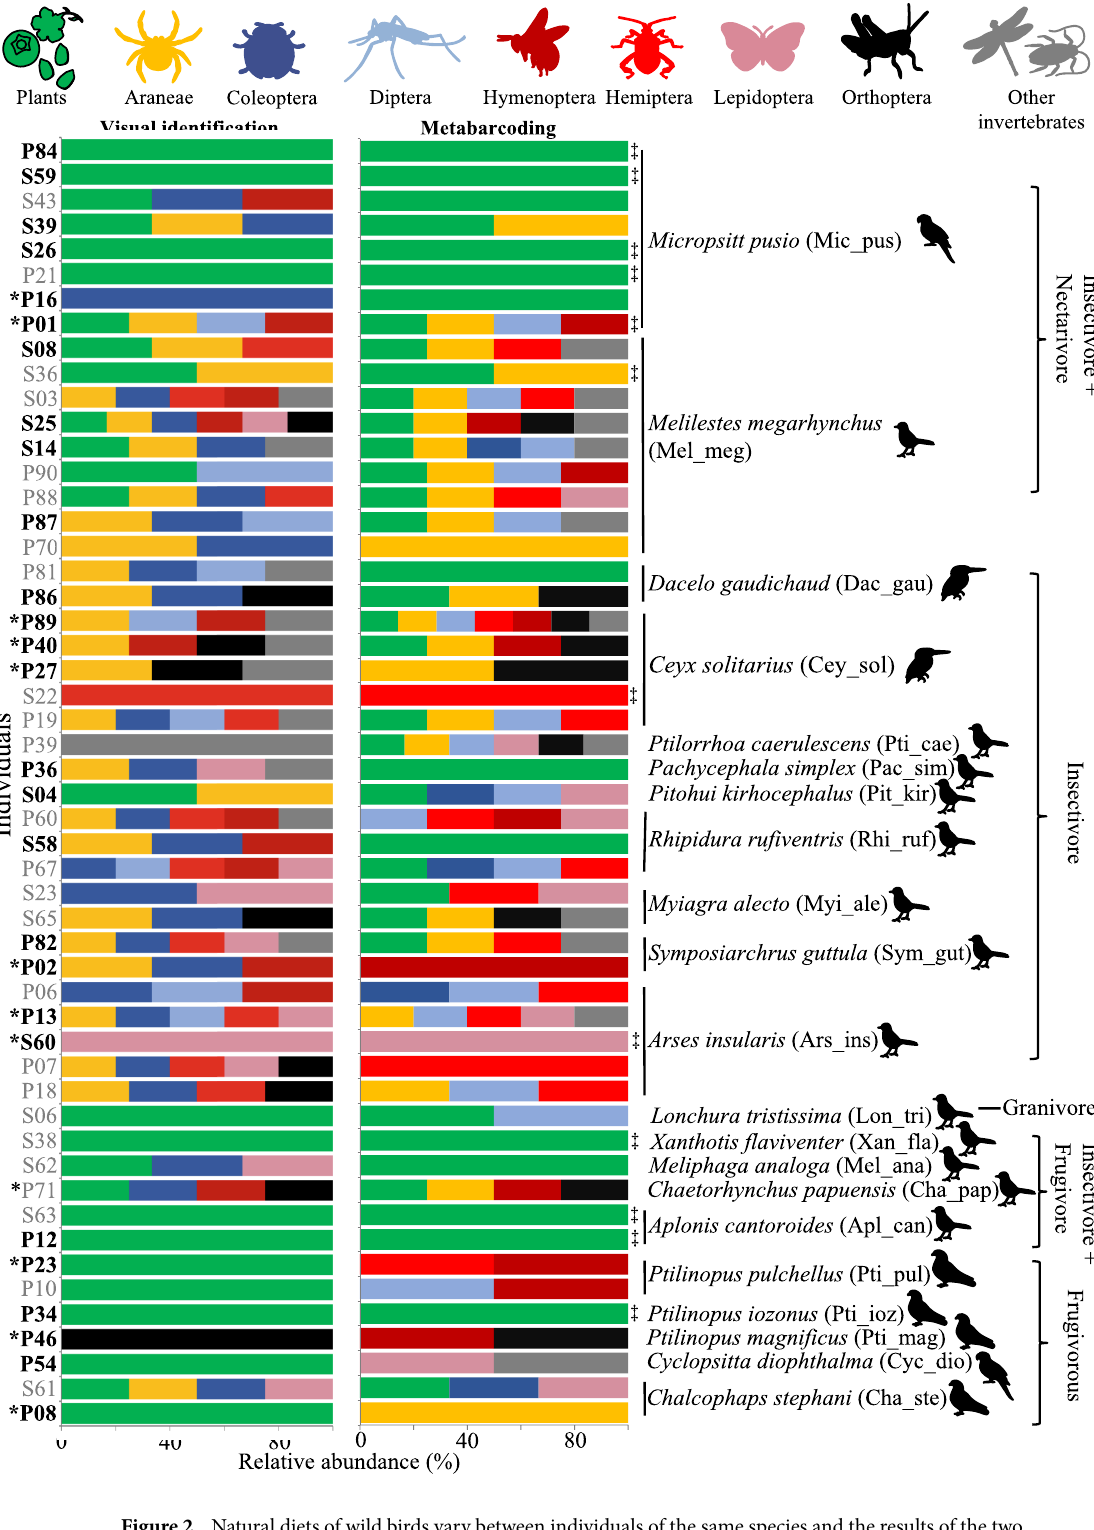
Figure 2. Natural diets of wild birds vary between individuals of the same species and the results of the two identification methods of dietary components (visual identification and metabarcoding). Relative abundances based on the presence/absence of data of different dietary components are indicated in colours. Only invertebrates are separated into taxonomic orders as visual identification is unable to identify plant orders. Individuals depicted with asterisks had both crop microbiome and diet samples (dataset 1), while black font represents individuals with both cloacal microbiomes and diet samples (dataset 2). Individuals are clustered according to the species (each species is given a six-letter code name) and their literature-based dietary guilds. The order of the species is indicated with illustrations (Columbiformes–Pigeons, Coraciiformes–Kingfishers, Passeriformes–Passerines and Psittaciformes–Parrots), while ‡ represents diet samples with a complete consensus between the two identification